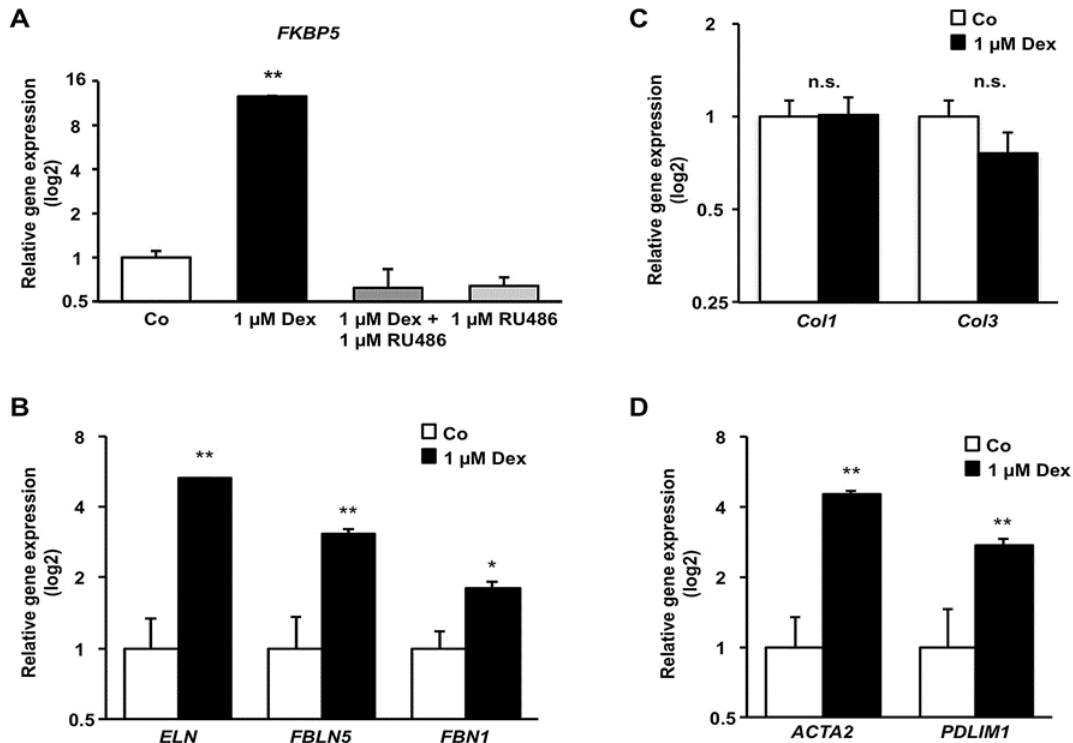
Figure 4. Dex treatment of HTPCs rapidly increases FKBP5 mRNA, a known target of GR signaling, and a ff ects mRNA levels of characteristic peritubular ECM markers, as well as cytoskeleton-associated genes. ( A ) Cultured HTPCs stimulated with Dex (1 µ M) in the absence or presence of RU486 (1 µ M), respond with a highly significantly increase ( p < 0.01) in FKBP5 mRNA levels after 6 h compared to control. RU486 completely blocks this e ff ect ( p < 0.01) and does not alter FKBP5 mRNA expression within 6 h. ( B ) After Dex treatment of HTPCs for 24 h, the mRNAs of the elastic fiber components ELN and FBLN5 are highly significantly ( p < 0.01) increased. A slightly smaller ( p < 0.05) increase is observed for FBN1 mRNA. ( C ) The transcript concentration of the collagen fibers Col1 and Col3 do not change ( p > 0.05) after application of Dex, while ( D ) the mRNAs of cytoskeleton markers ACTA2 and PDLIM1 ( n = 8) are enriched ( p < 0.01) after stimulation of HTPCs with Dex. Data are means ±